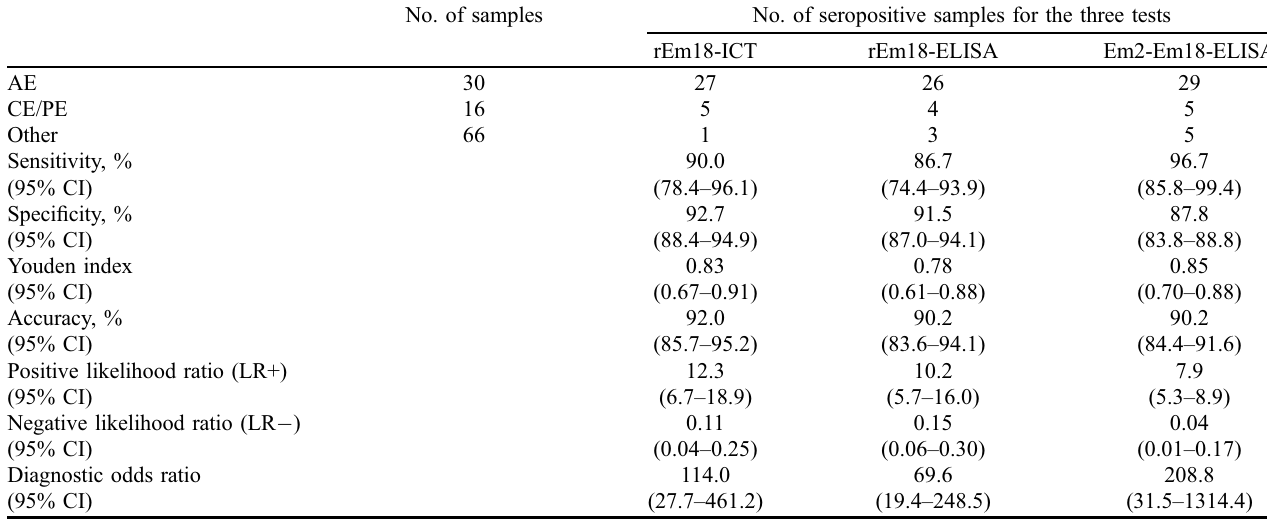
Table 1. Results for ELISA tests rEm18 and Em2-Em18, and rEm18-ICT for AE (alveolar echinococcosis), CE and PE (cystic and polycystic echinococcosis), and other pathologies. Percentages of sensitivity, specificity, and the performance index for each test are shown. No. of